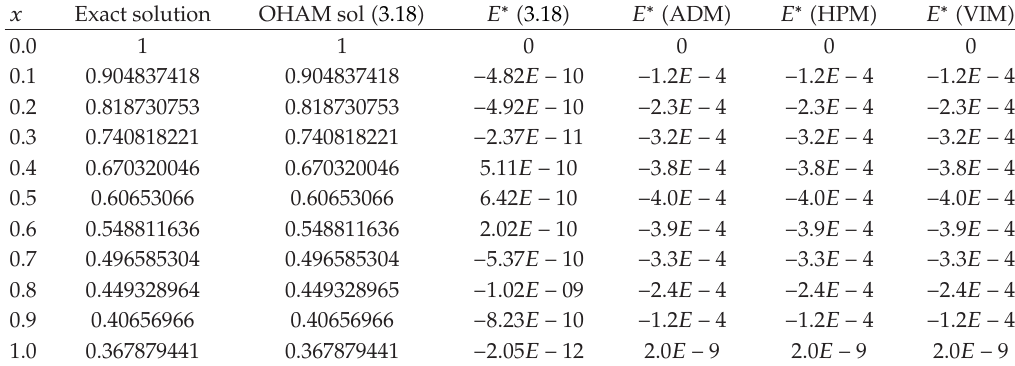
Table 4: It shows comparison of the OHAM solution (cid:2) 3.18 (cid:3) with the exact solution and the errors obtained by decomposition method (cid:2) ADM (cid:3) (cid:7) 19 (cid:8) , homotopy perturbation method (cid:2) HPM (cid:3) (cid:7) 24 (cid:8) , and the variational iteration method (cid:7) 22 (cid:8) . It is clear from the results that the method we applied is more e ffi cient and accurate than the other